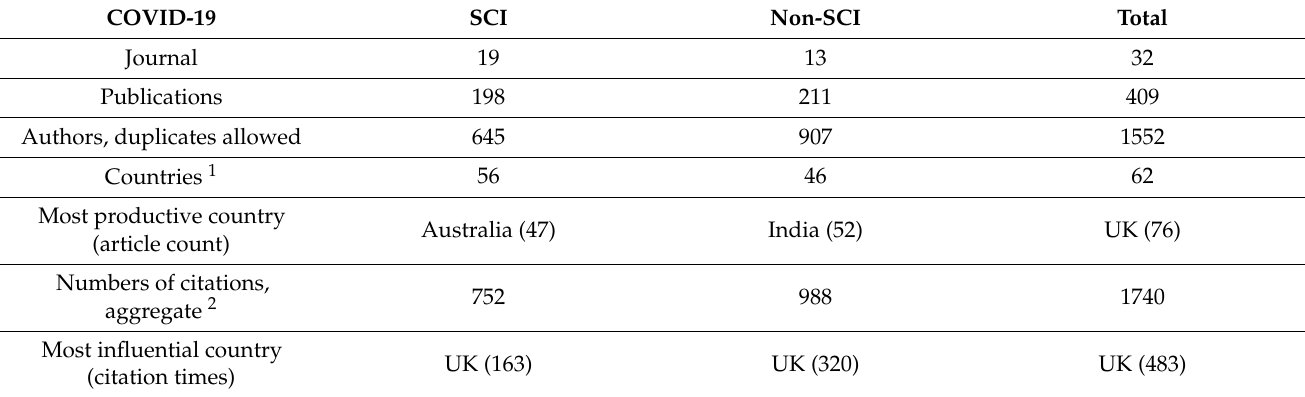
Figure 2. Publication of COVID-19-related articles in family medicine journals in time distribution. In 2020, there were 409 COVID-19-related articles published in family medicine jour- nals by 1552 authors from 62 countries (Table 3). The country with the highest number of publications was UK with 76 articles, accounting for 18.6% of all COVID-19-related articles, followed by USA with 58 articles, accounting for 14.2% of all articles. The third country was India with 56 articles, accounting for 13.7% of the articles. China, where the disease originated, published 11 articles, accounting for 2.7%. SCI journals with the most publications were from Australia, with 47 publications, accounting for 23.7% of all SCI journals in family medicine publications. Among the non-SCI journals, journals with the most publications were from India with 52 publications, accounting for 24.6% of all non-SCI journals in family medicine journals. In terms of impact, the country with the highest number of citation times in family medicine journals was UK, with 483 citations, followed by USA, with 231 citations. Table 3. Profiles of COVID-19-related articles in family medicine journals from PubMed in 2020.